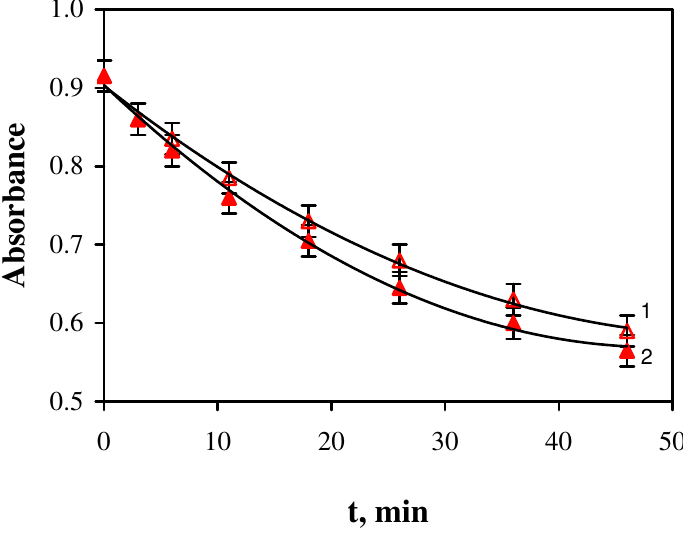
Fig. 1 Absorbance changes with time (kinetic curves) of 90 µ M meta-chloroperoxybenzoic acid by CAT/TiS in acetonitrile; temperatures: 1) 10 ◦ C; 2) 25 ◦